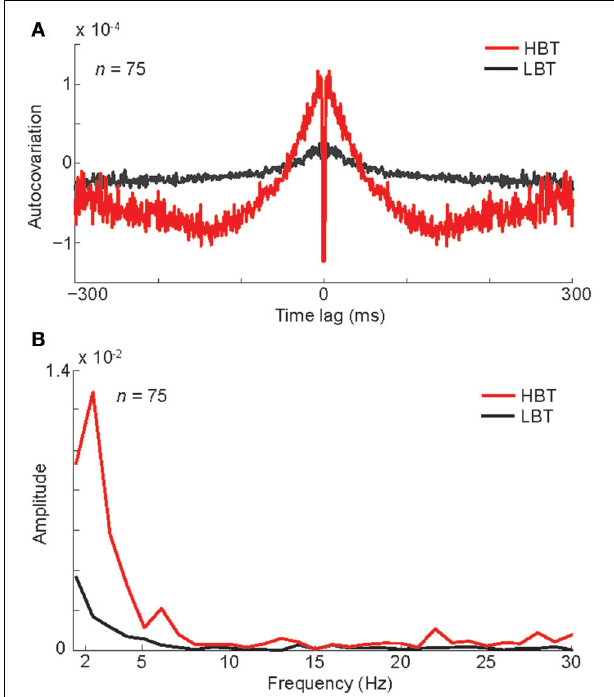
FIGURE 3 | Oscillation associated with different levels of baseline activity. (A) The auto-covariation plot for high baseline trials (HBT) and low baseline trials (LBT), measured during the baseline period ( − 300–0ms). Low auto-covariation within 2ms of the central time bin reflects the absolute refractory period of the isolated single units. (B) The FFT amplitude of the auto-covariation in HBT and